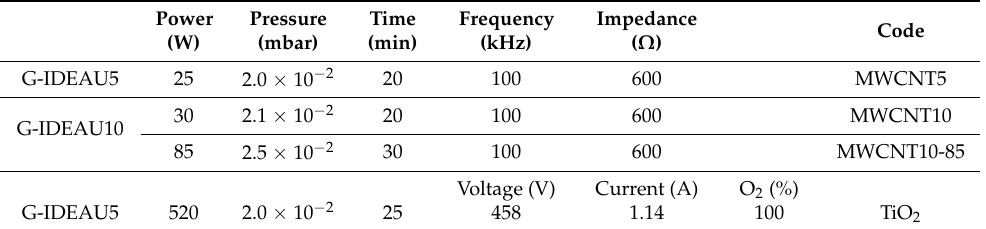
Table 2. Sputtering conditions for the deposition of MWCNTs and TiO 2 thin films onto BK7